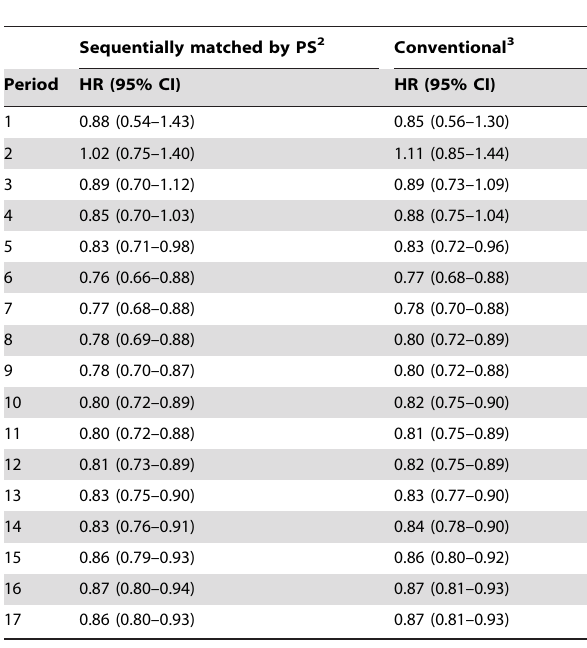
Table 2. Comparative effectiveness of atorvastatin (10 mg) versus simvastatin (20 mg).